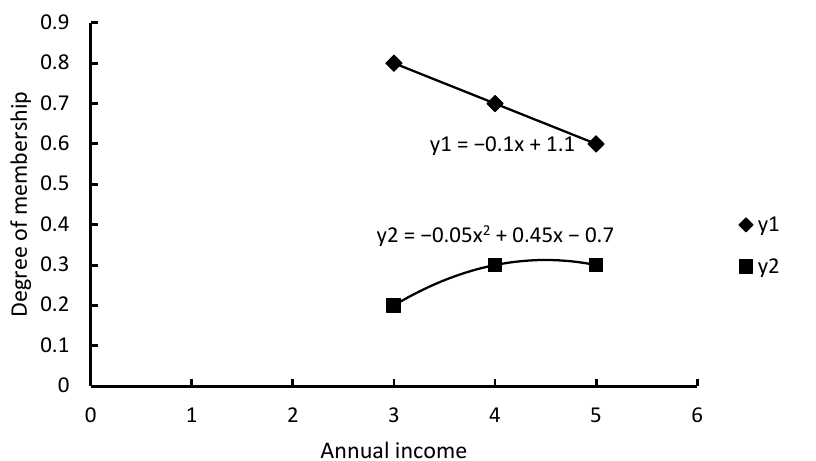
Figure A7. Single factor evaluation for the index of total assets (more than 100 ten thousand yuan).